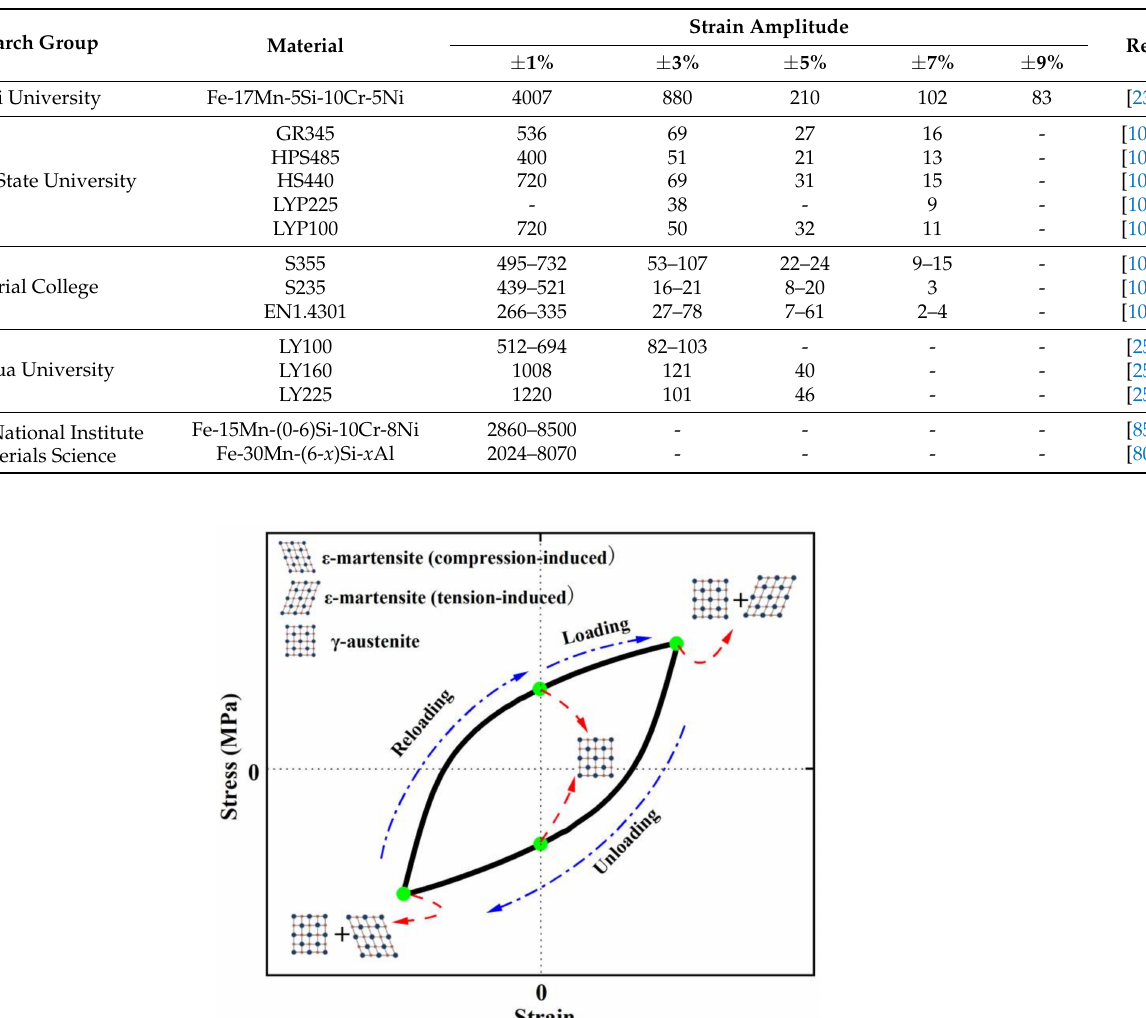
Figure 10. Comparison of fatigue lives between Fe-SMA and other typical metals [23,108,109]. Table 5. Numbers of cycles to failure of different metals.